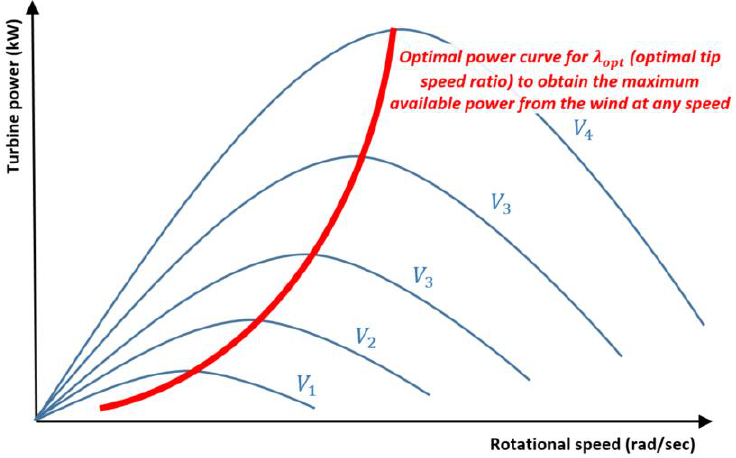
Figure 11. Wind rotor power vs. rotational speed for different wind speeds.